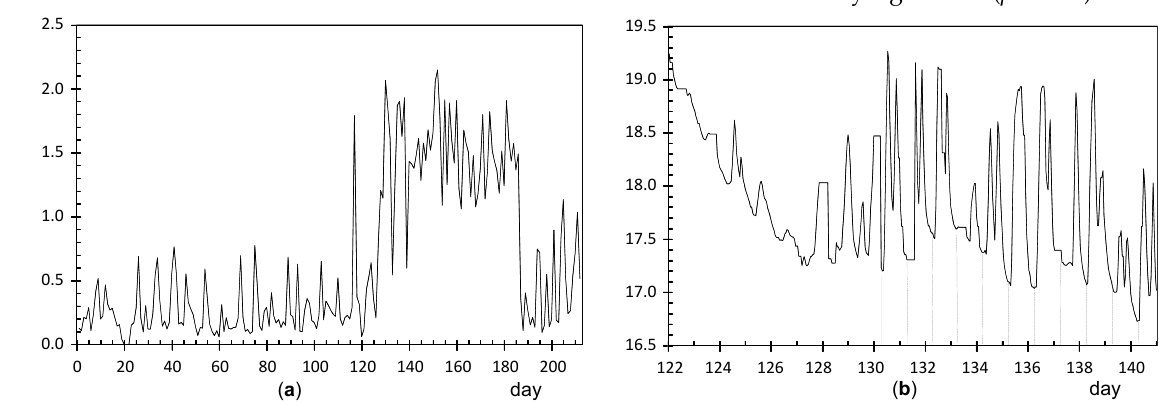
Figure 9. Node LO3: ( a ) time series of daily ranges of temperature ( ◦ C) for the 212 days, ( b ) time series of hourly values of temperature ( ◦ C) from day 122 (30 November) until day 140.